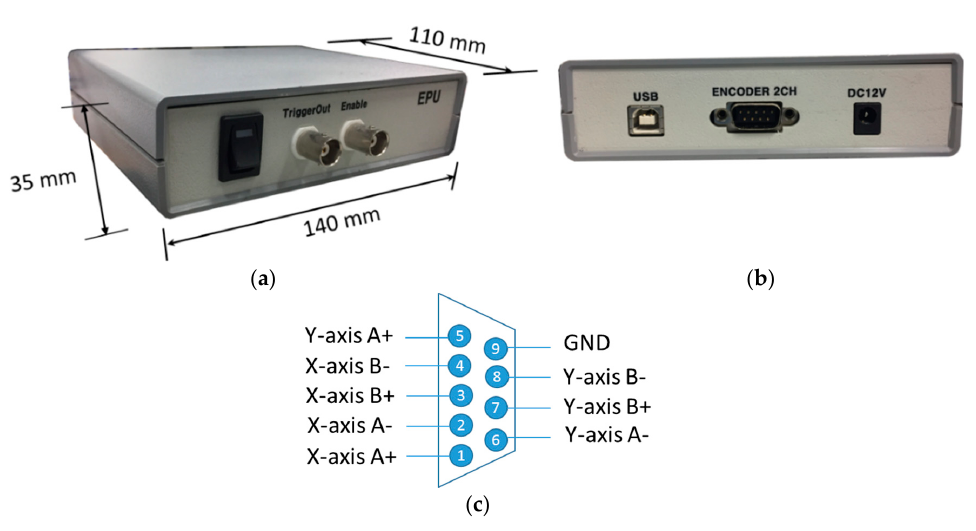
Figure 4. EPU prototype. ( a ) Front panel; ( b ) back panel; and ( c ) encoder wiring configuration.